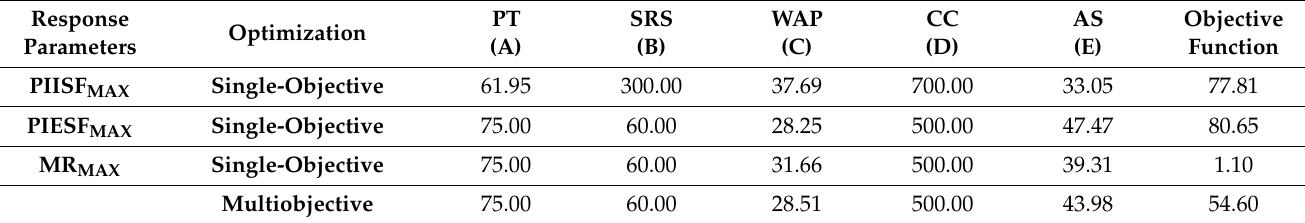
Figure 8. Flow chart used for multiobjective optimization. The genetic algorithm was performed using MATLAB, and optimization results are represented in Table 6. The multiresponse optimization solution indicated that the values of PT, SRS and CC are different for PIISF but remain constant for PIESF and MR in optimization solutions. Moreover, the values of WAP and AS are different for all optimization conditions. Table 6. Multiresponse optimization outcomes using genetic